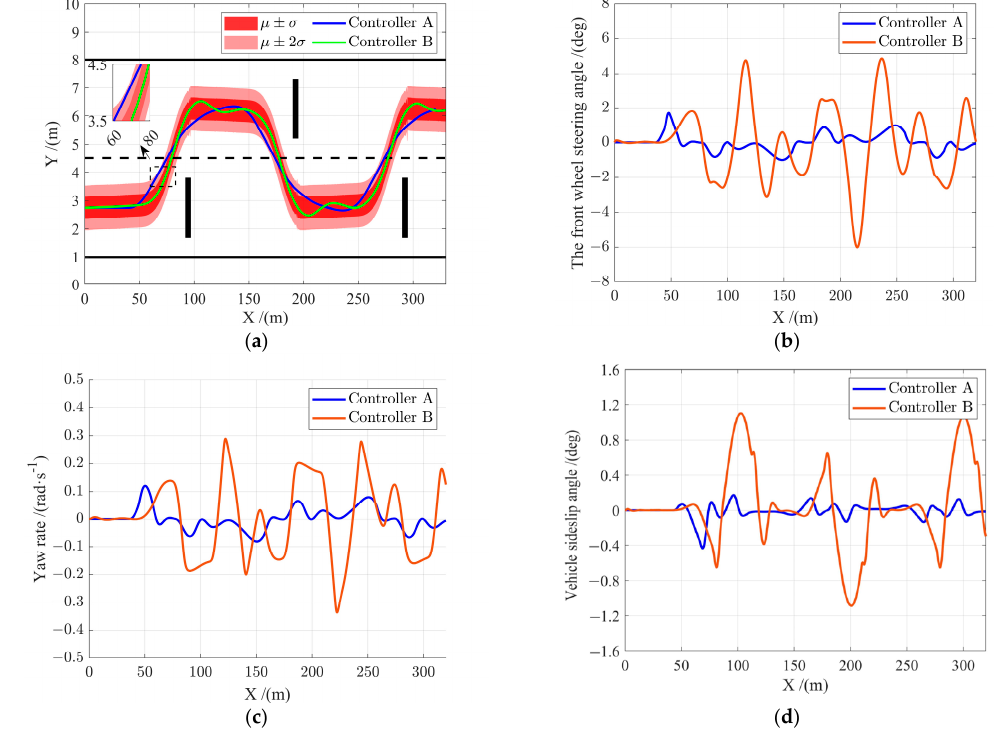
Figure 8. Experimental results of obstacle avoidance with ground adhesion coefficient 0.2. ( a ) GPR − based obstacle avoidance envelope and the obstacle avoidance trajectories. ( b ) The front wheel steering angle. ( c ) Yaw rate ( d ) Vehicle sideslip angle.